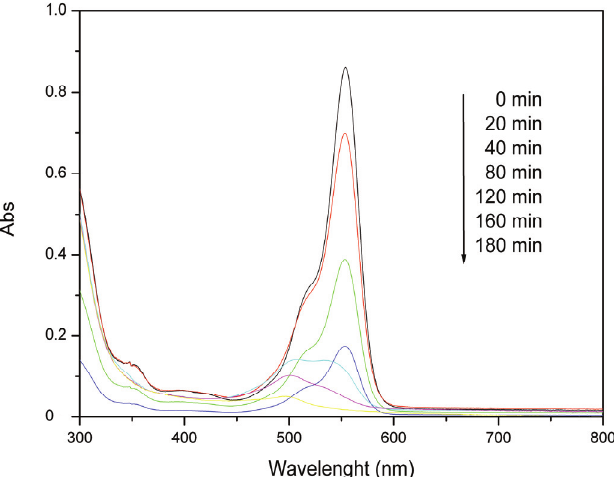
Figure 7. Absorption spectrum of RhB dye degraded under visible light irradiation for 180 min using the TOB1